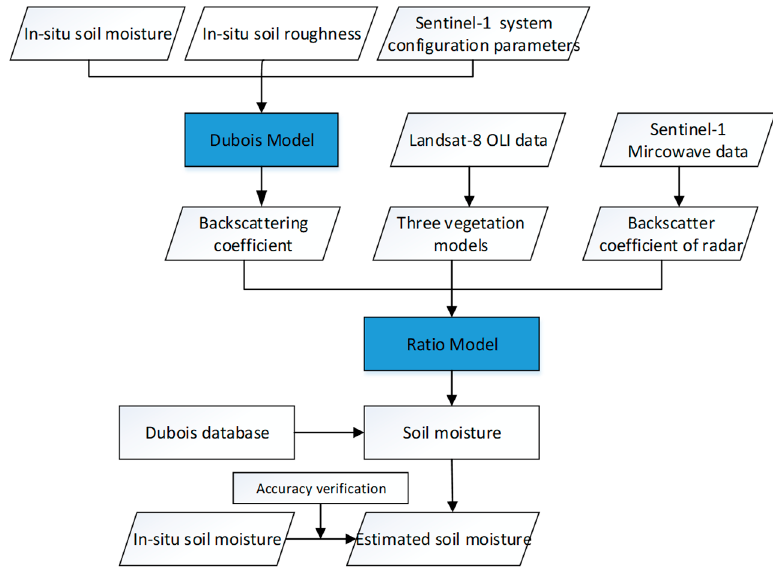
Figure 4. Flowchart for the soil moisture retrieval.